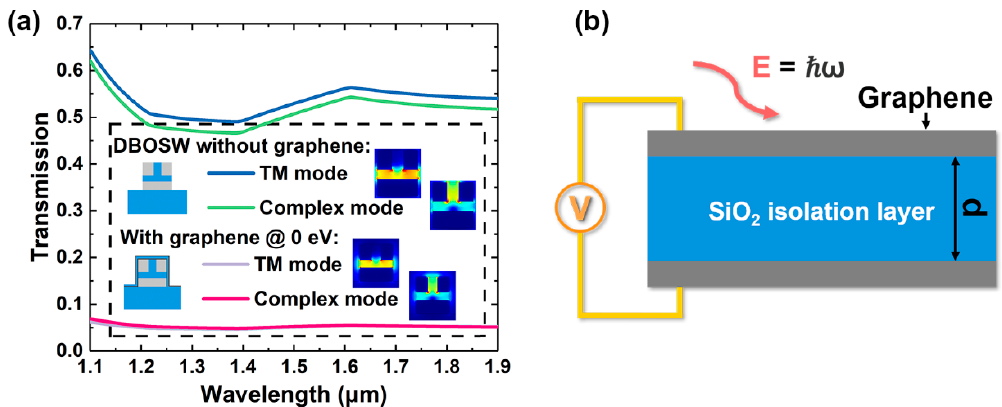
Figure 2. (a) Transmission spectrum of the dual built-in orthogonal slots waveguide (DBOSW) with and without graphene; (b) optical absorption in the graphene capacitor structure.